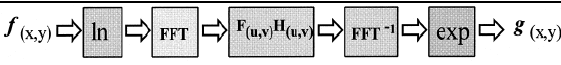
Figure 1. Test snapshots with different parameters: (a) S S: 2”, White Fluorescent